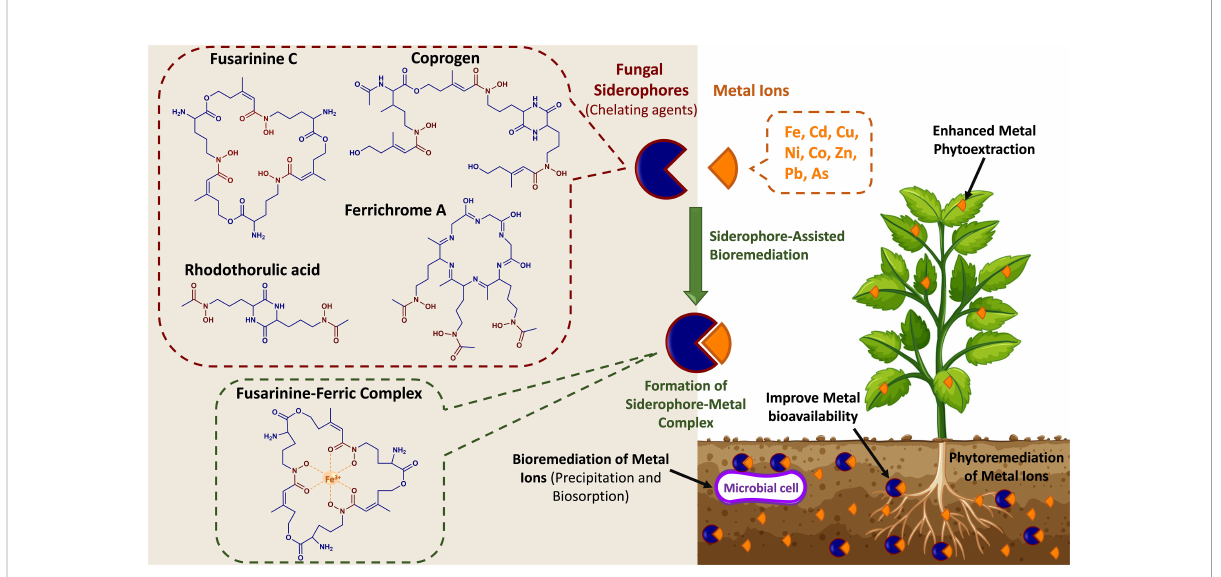
FIGURE 3 Conceptual representation of the phytoremediation of metal ions by fungal siderophores. The chemical structures of selected fungal siderophores (fusarinine C, ferrichrome A, coprogen, and rhodothorulic acid) and an example of a siderophore-metal complex (Fusarinine C- ferric